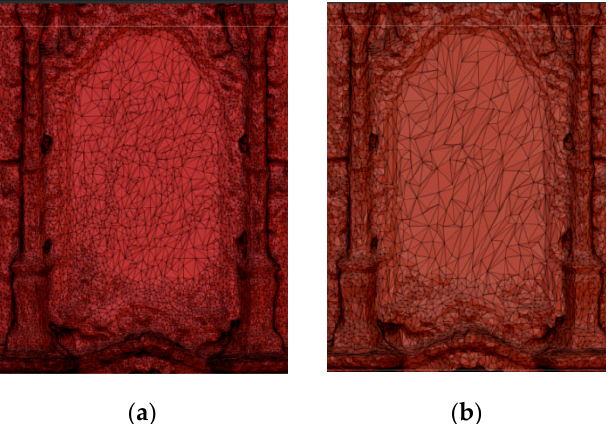
Figure 4. ( a ) High-poly before the optimization (reducing polygon count) ; ( b )High-poly model after Decimation Master tool.